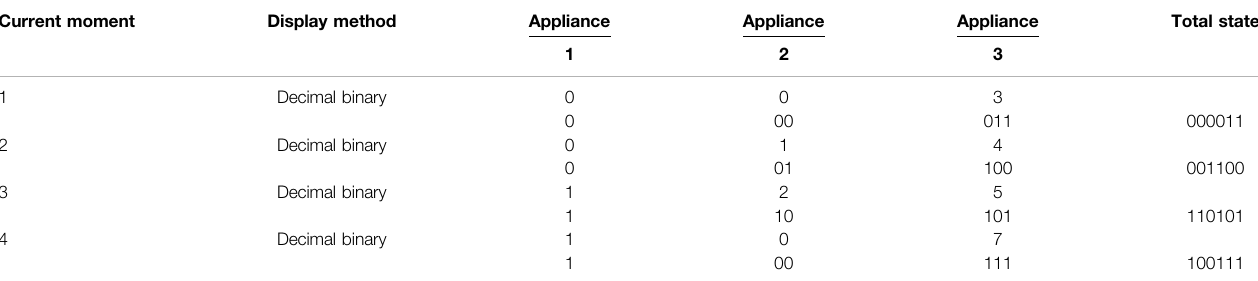
TABLE 1 | State code of some electrical